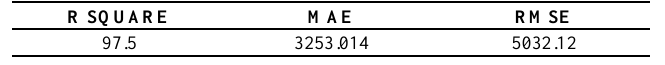
Table 7. The obtained error values in MLP model using factors in this work.